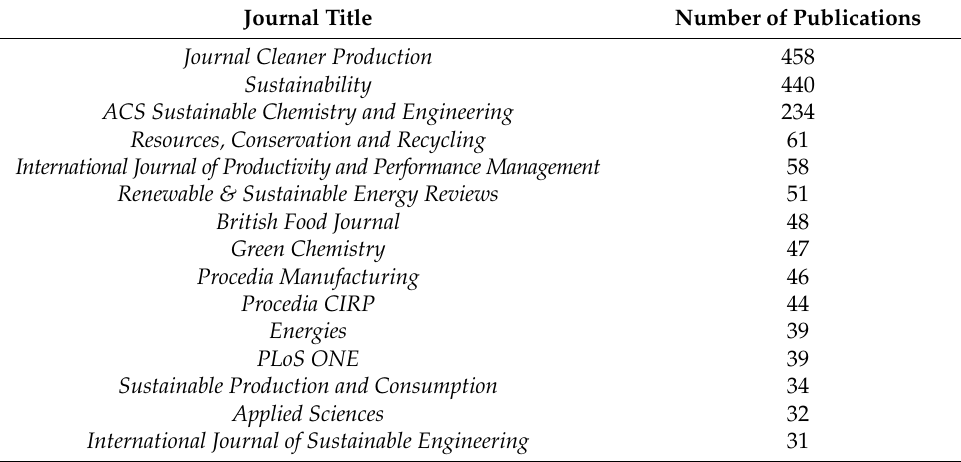
Table 2. The main journals published in using “sustainable product